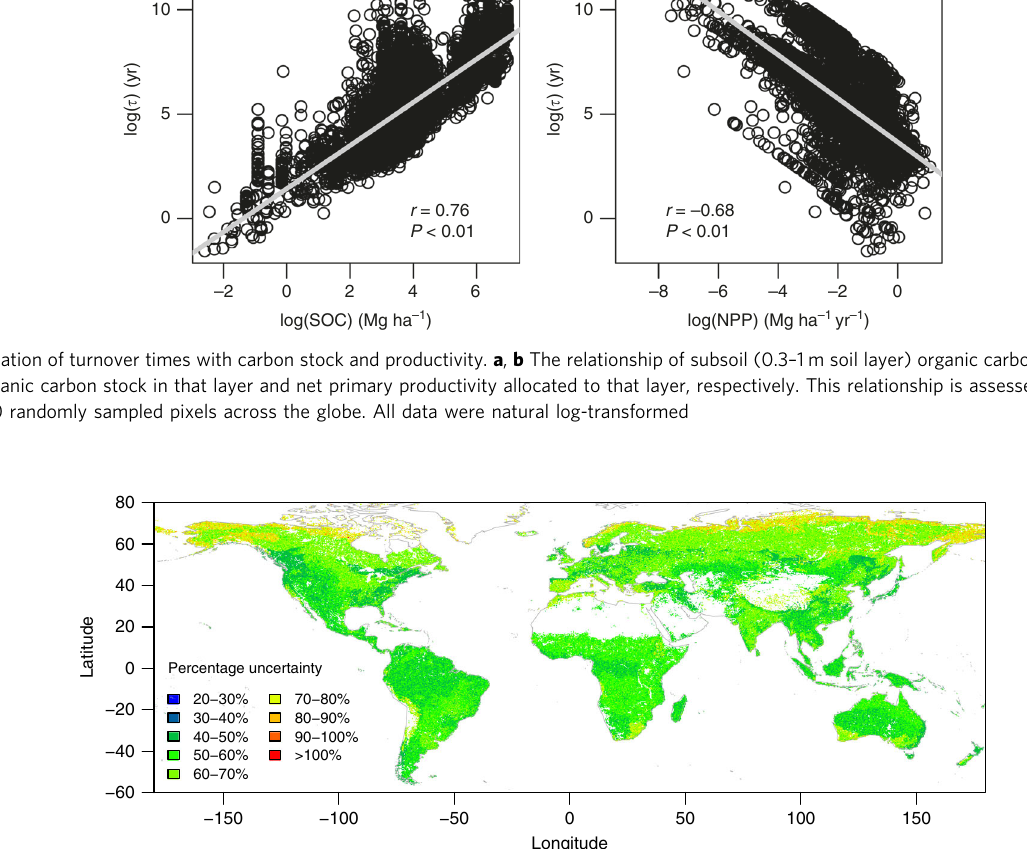
Fig. 3 Percentage uncertainty of subsoil organic carbon turnover times. It is calculated as the percentage ratio of the difference between the upper and lower limits of the 95% con fi dence interval to the mean of 200 bootstrapping simulations considering uncertainty in carbon input in each pixel at the resolution of